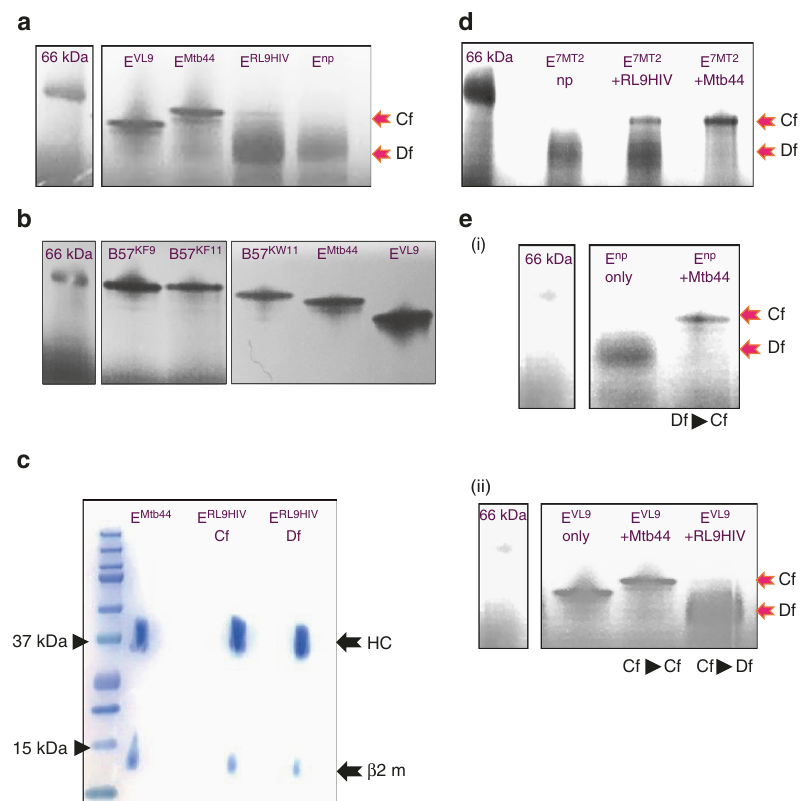
Fig. 5 Blue-native-PAGE analysis of HLA-E complexes. a Blue-native (BN) gel signature of refolded HLA-E complexes. Puri fi ed HLA-E- β 2m complexes refolded without peptide (no peptide (E np )) or in the presence of RL9HIV (E RL9HIV ), Mtb44 (E Mtb44 ) or VL9 (E VL9 ) peptides were visualised by BN-PAGE gel. Red arrows indicate protein gel forms comprising compact (Cf) and diffuse (Df) species. The 66 kDa protein marker is highlighted for reference. b HLA-E compact (Cf) gel signatures resembled MHC class Ia folded proteins. Puri fi ed HLA-B57- β 2m complexes refolded in the presence of the previously de fi ned KAFSPEVIPMF (B57 KF11 ), KAAFDLSFF (B57 KF9 ) and KAYDTEVHNVW (B57 KW11 ) epitopes were visualised by blue-native (BN) PAGE gel for comparison to HLA-E complexes refolded with VL9 and Mtb44. The 66 kDa protein marker is noted for reference. c 2D analysis of BN-gel resolved HLA-E- peptide refolds. BN-gel separated HLA-E-RL9HIV and HLA-E-Mtb44 complexes were 2D resolved via NuPAGE 10% Bis-Tris using standard 12-well lane gels where individual BN-gel slices were excised and individually separated. Heavy chain (HC) and β 2m bands are noted (black arrows), and reference protein size markers are displayed (arrowheads). d BN-gel signatures of UV peptide labile-HLA-E complexes (E 7MT2 ) following RL9HIV, Mtb44 and no peptide rescue. Pre-puri fi ed HLA-E molecules in complex with UV-labile 7MT2 were illuminated without peptide (np) or in the presence of RL9HIV and Mtb44 epitopes. The material was subsequently resolved by BN-gel. Red arrows indicate protein gel forms. The 66 kDa protein marker is noted for reference. e Exogenous peptide loading into no peptide and VL9-refolded HLA-E complexes. Puri fi ed HLA-E- β 2m complexes refolded ( i ) without peptide (E np ) were pulsed with 50 M excess Mtb44 peptide ( ii ) and pre-refolded HLA-E VL9 peptide complexes (E VL9 ) were pulsed with 200 M excess Mtb44 or RL9HIV peptides after which BN-gel signatures were analysed. Gel signature transitions are noted (text beneath images). Abbreviations throughout: